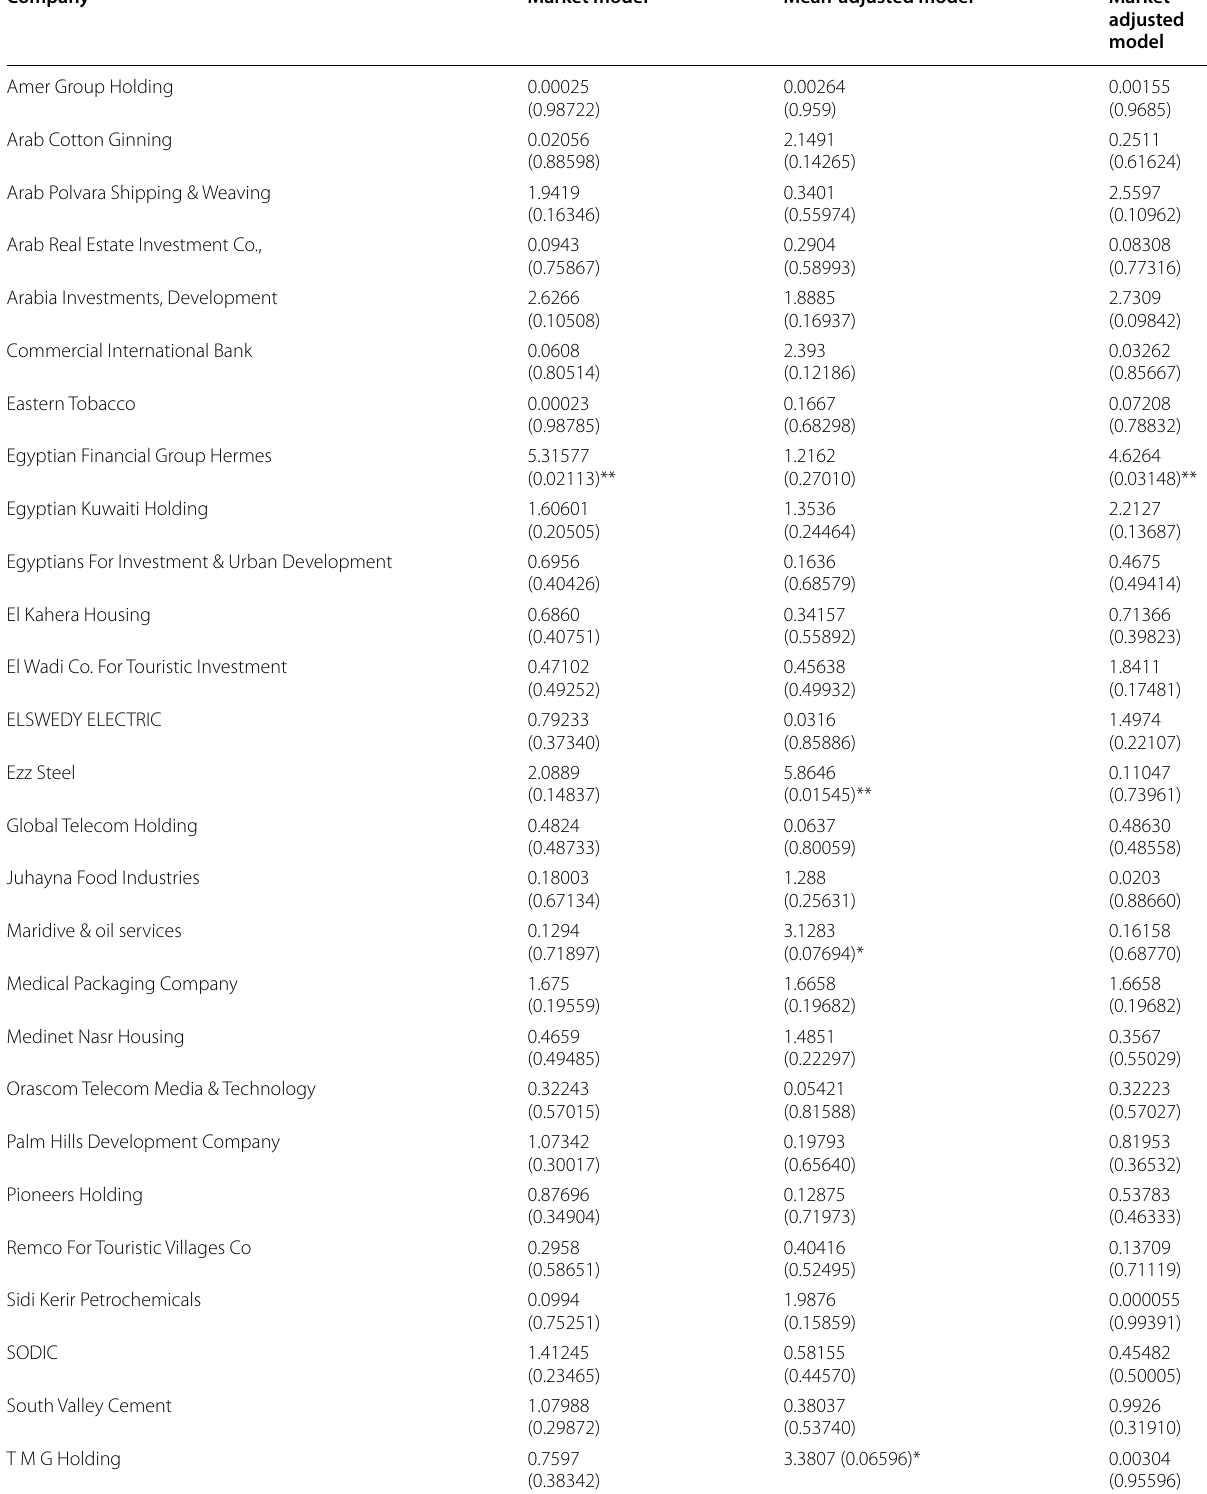
Table 2 The results of Breusch–Pagan/Cook–Weisberg test for